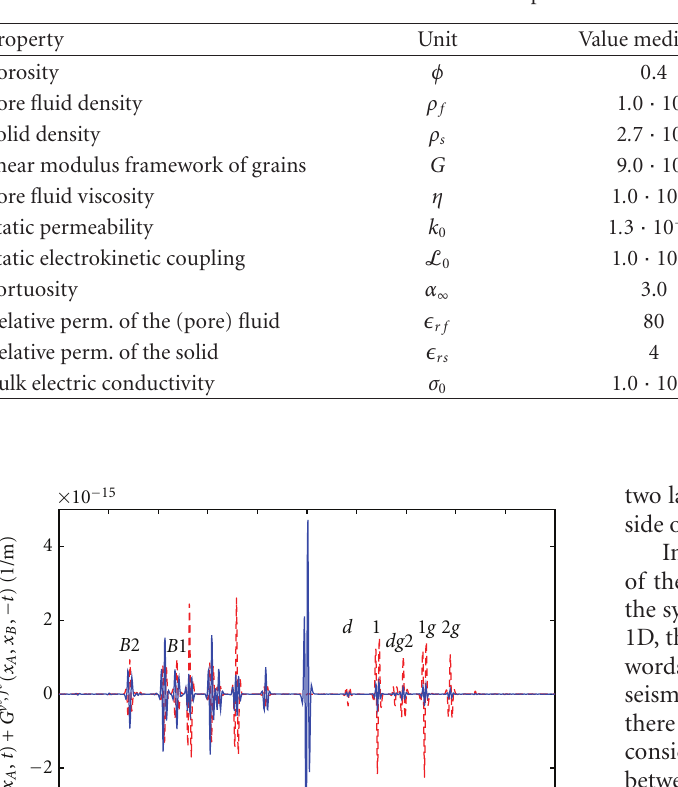
Table 3: Overview of the relevant medium parameters for the 1D seismoelectric interferometry model.